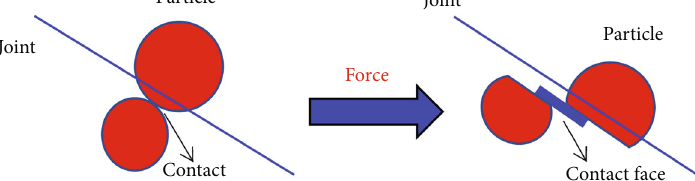
Figure 3: Smooth joint model in PFC 2D .